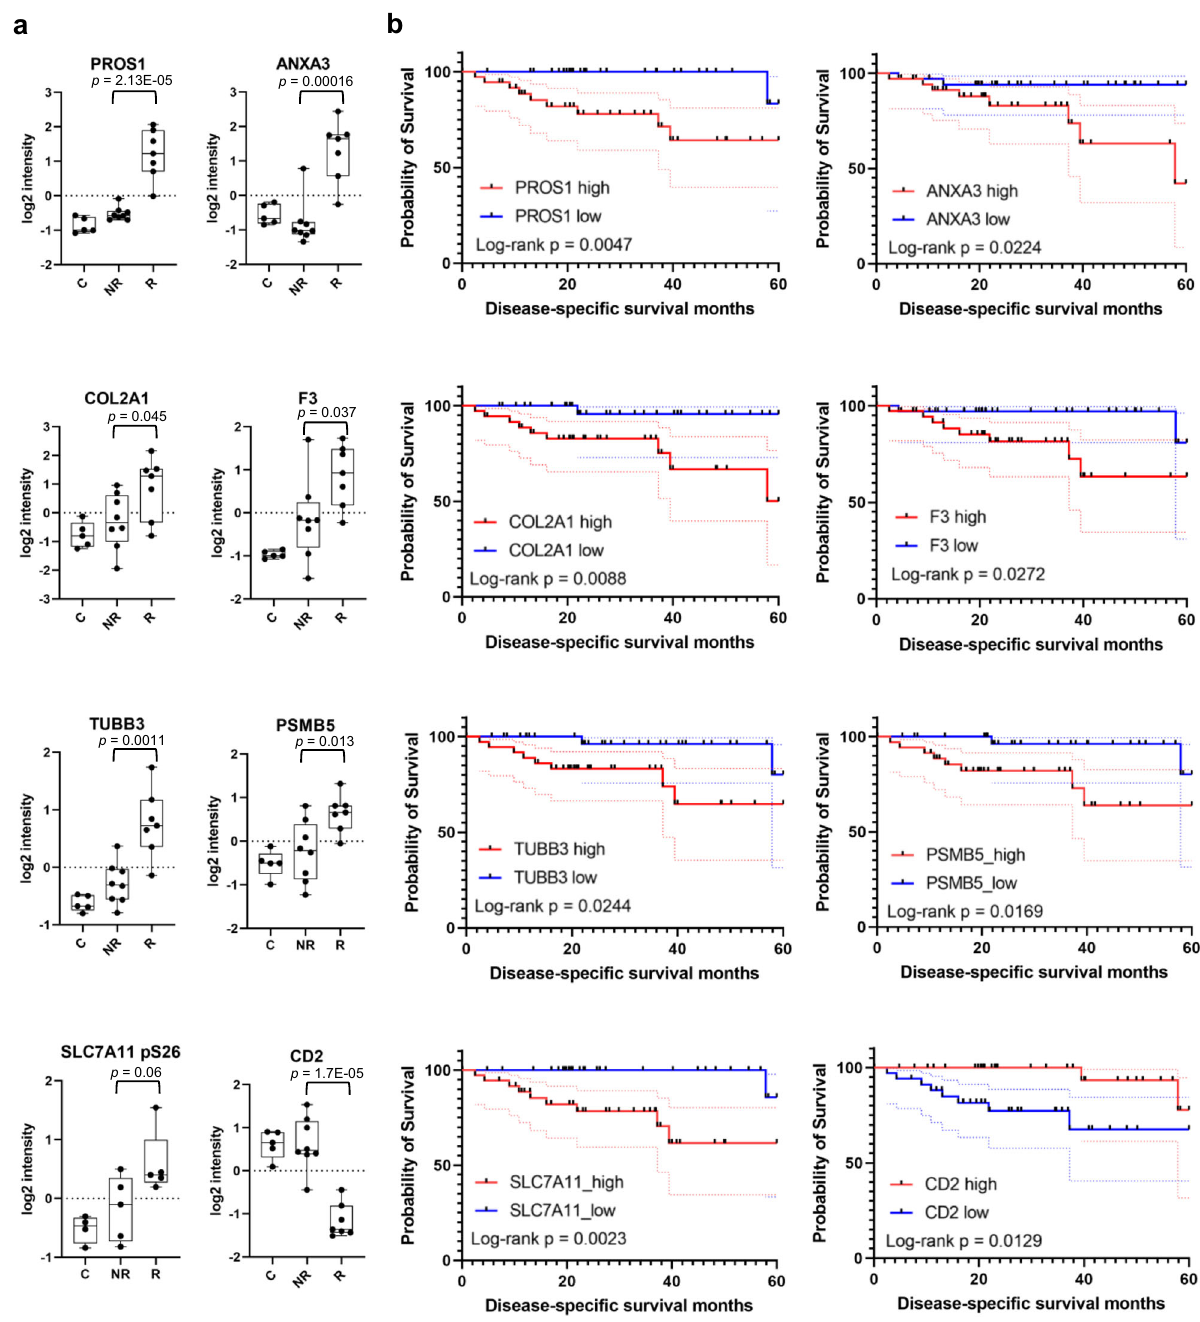
Fig. 7 Potential biomarkers for predicting recurrence and survival. a Box plots of representative biomarkers emerging from this study. P values shown were based on Student ’ s t -test. FDA-approved drugs are available for the upregulated proteins shown here. The box in the box plot extends from the 25th to the 75th percentile. The whiskers go down to the smallest value and up to the largest. n = 8 for the NR group, and n = 7 for the R group. b Kaplan-Meier analysis showing that low expression of the fi brosis and in fl ammation markers or high expression of the T cell marker CD2 are correlated with longer survival. P values were based log-rank test. The TCGA HPV + HNSCC ( n = 71) cohort was used in the survival prediction. For each gene, the 71 patients were divided into high expression ( n = 36) or low expression ( n = 35) group, and the disease-speci fi c survival months were plotted. The dotted lines show 95% con fi dence